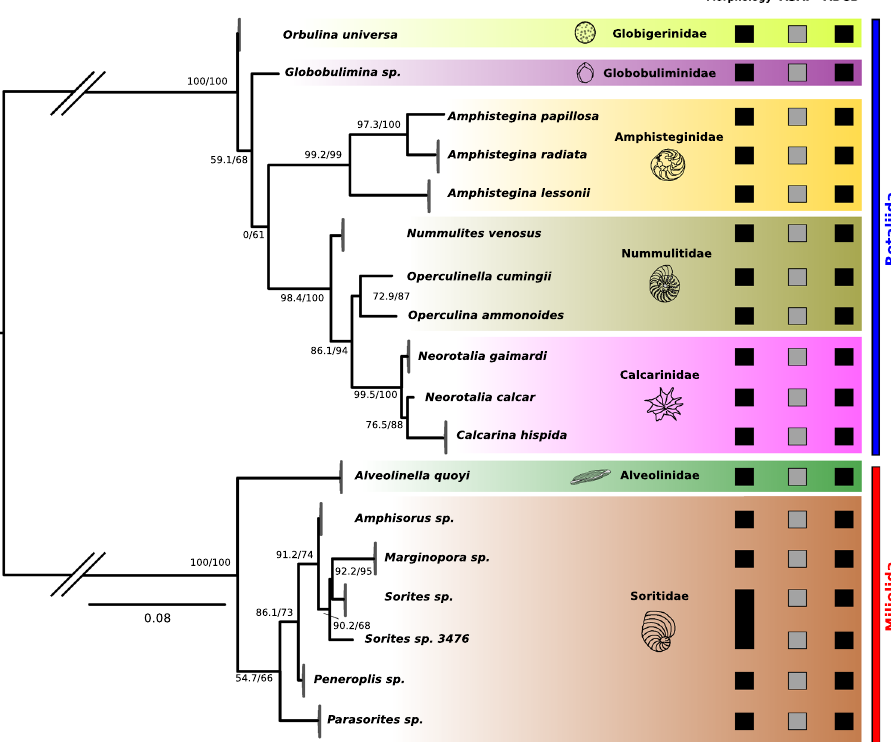
Figure 1. Phylogenetic tree showing evolutionary relationships of Foraminifera inferred from the Leray fragment of the mitochondrial COI gene. Numbers at nodes indicate bootstrap values (Maximum Likelihood) and posterior probabilities (Bayesian Inference). Branches within species are collapsed. Morphological identification and ASAP and ABGD delimitation results are shown. Squares indicate species/clusters identified based on morphology, ASAP and ABGD, respectively. Branches leading to Miliolida and Rotaliida, respectively, are shortened to improve